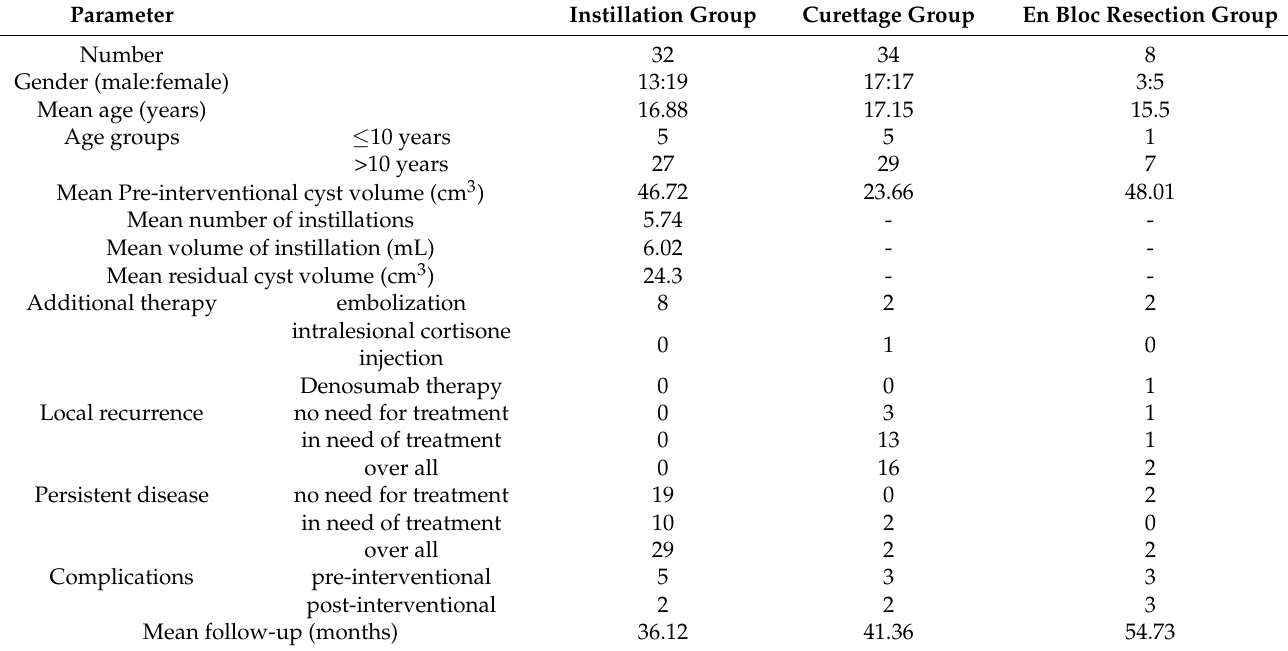
Table 2. Overview of the study cohort.